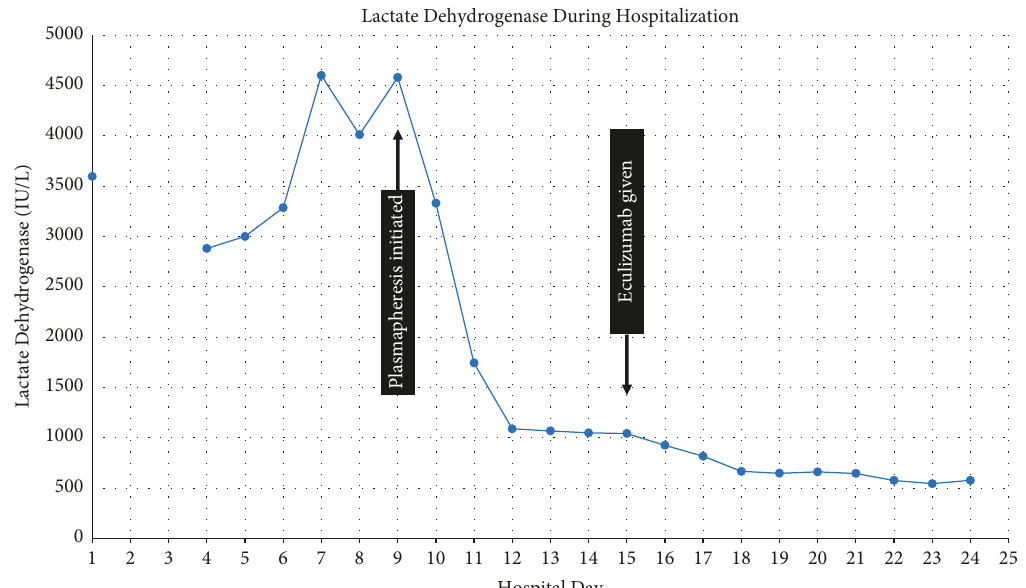
Figure 4: Lactate dehydrogenase (LD) trend in IU/L throughout hospitalization. The plasma exchange was initiated on hospital day 9, and eculizumab was given on hospital day